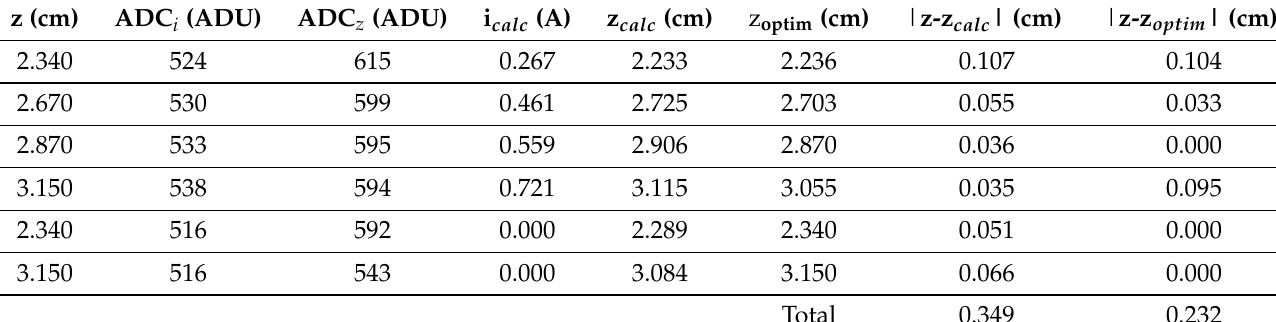
Table 4. Optimization of the sensor constants